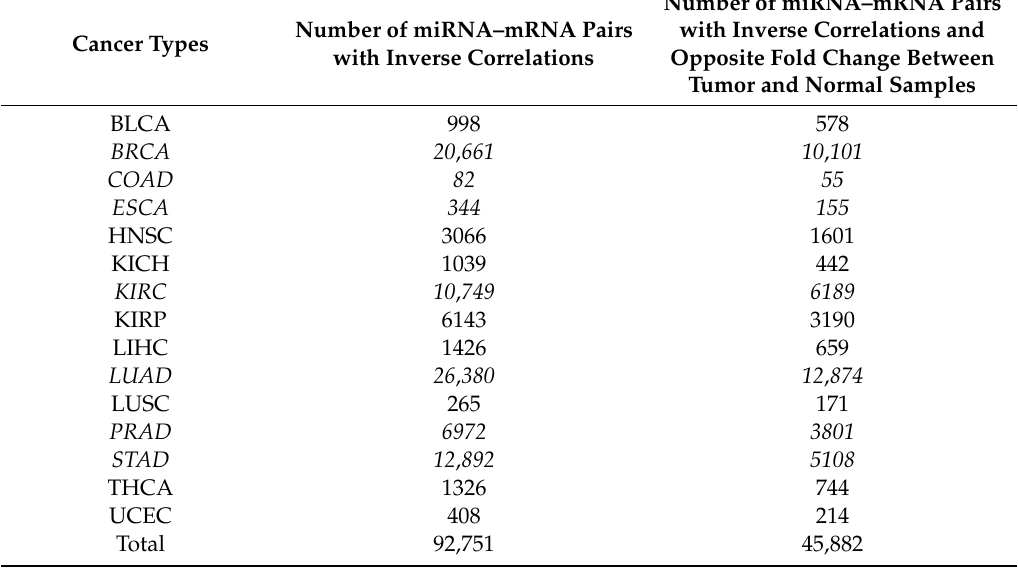
Table 1. The statistics for number of miRNA–mRNA pairs in 15 selected cancers from The Cancer Genome Atlas